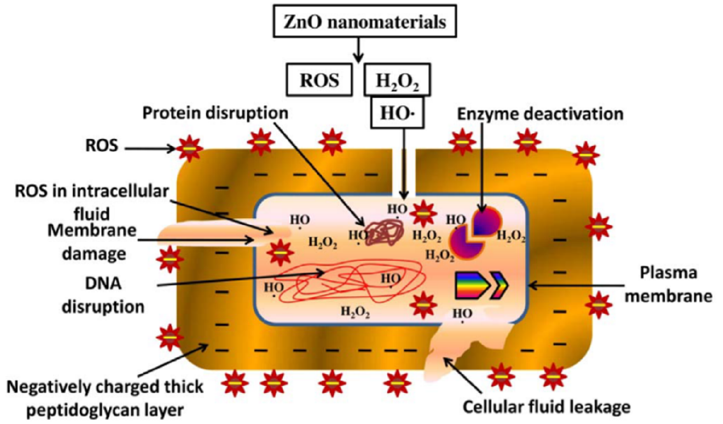
Figure 11. Schematic diagram of cell damage to G+ bacteria by Zn 2+ ions. Reprinted/adapted with permission from Ref. [27]. Copyright© 2022 Elsevier B.V.